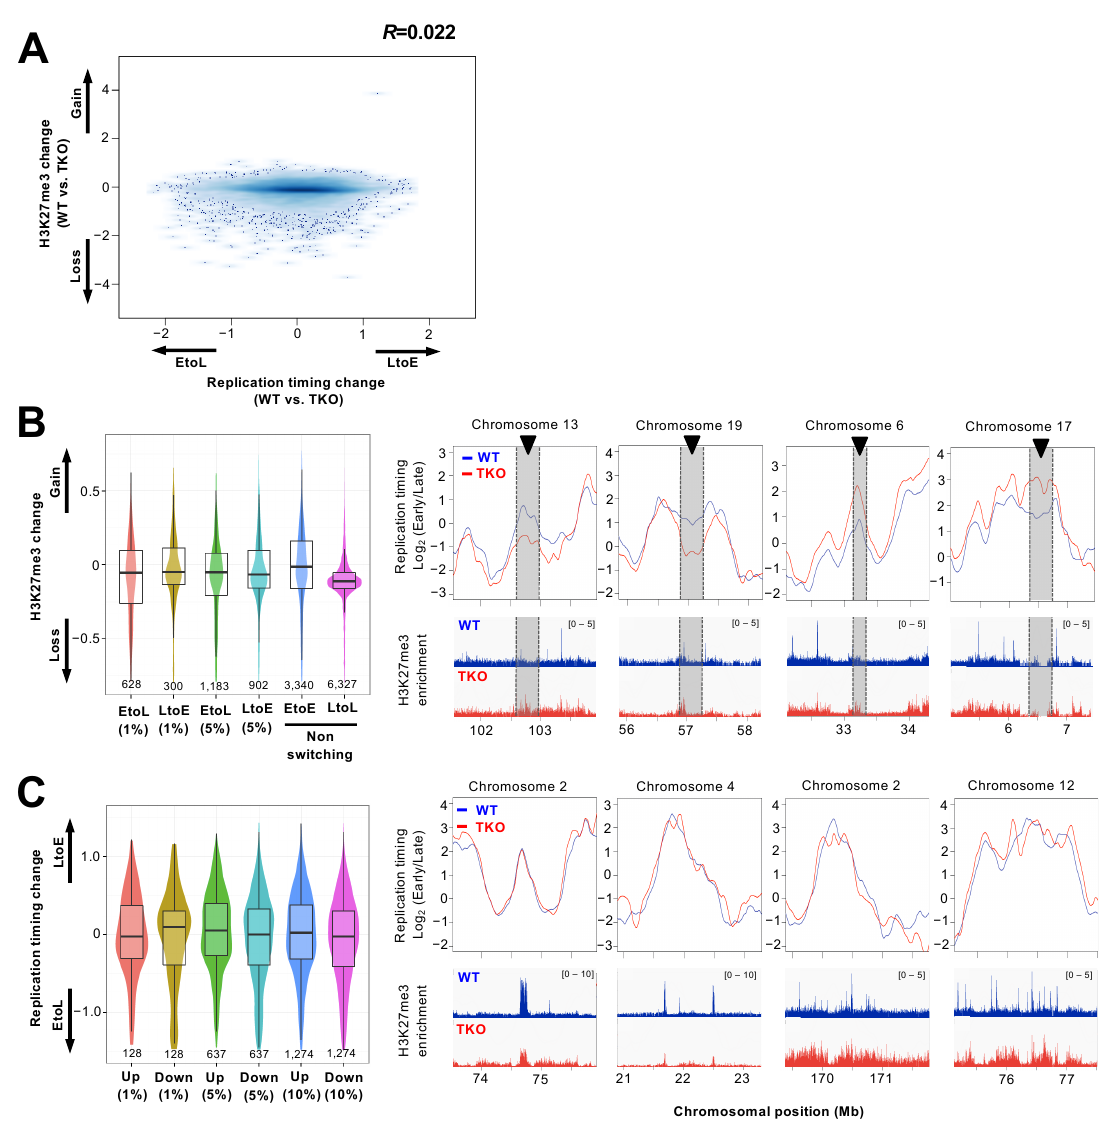
Figure 3. Genome-wide comparison of replication timing changes and H3K27me3 redistribution in TKO cells. ( A ) Redis- tribution of the H3K27me3 mark relative to changes in replication timing. Replication timing changes after Dnmt loss (TKO ESC log 2 ratio − WT ESC log 2 ratio) were plotted against the changes in H3K27me3 enrichment (TKO ESC − WT ESC) identified by ChIP-seq [48]. Replication timing data averaged over 200-kb segments and enrichment of H3K27me3 in each corresponding segment (12,732 segments in total) were used to calculate differences between WT and TKO. ( B ) Box plots showing the changes in H3K27me3 enrichment in EtoL and LtoE switching regions after Dnmt loss (for segments with an FDR = 1% and 5% from Figure 2C) compared with non-switching early (EtoE) or late (LtoL) regions. The number of 200-kb segments analyzed is indicated below each plot. IGV genome browser tracks illustrating the distribution of H3K27me3 within representative replication timing switching regions (from Figure 2E) are shown to the right. The scale for H3K27me3 enrichment is shown in the upper right corner. ( C ) Box plots showing the replication timing changes in genomic regions scoring in the top 1%, 5%, and 10% in terms of H3K27me3 gain and loss. The number of 200-kb segments analyzed is indicated below each plot. The replication timing profiles for representative regions undergoing redistribution of the H3K27me3 mark after Dnmt loss are shown to the